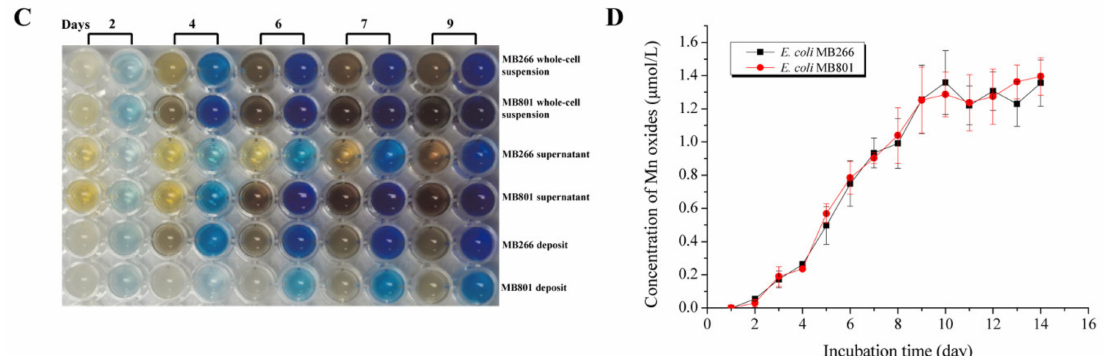
Figure 4. Growth curve ( A ) and MnODA ( B , D ) measurements and LBB test ( C ) on culture fractions of the mutant strain MB801. In ( A ), the wild-type MB266 was used as the control. The OD 600 values were comparatively determined based on the approximately equivalent inoculum size of both strains. In ( B ), MnODA (refers to concentration of Mn oxides) of the deposit fraction of the MB801 culture was determined following the culturing of the cells for 5 days in LB broth containing 5 mmol/L MnCl 2 at the final concentration. In ( C ), LBB test results are shown for the culture fractions of MB801 in 96-cell microtiter plates after culturing for 5 days in LB broth containing 5 mmol/L MnCl 2 at the final concentration. In ( D ), MnODA (refers to concentration of Mn oxides) was determined over a culture time course of 5 days in Lept medium containing 100 µ mol/L Mn(III) complex at the final